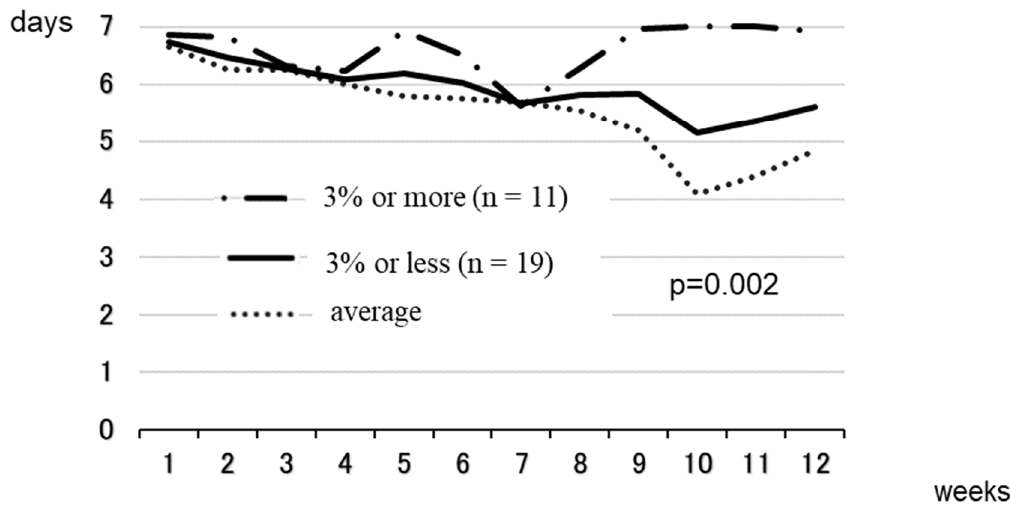
Figure 3. Mean days of wearing BCCG in each week for participants with 3% or more weight loss and those with 3% or less weight loss. BCCG, body compression corrective garment. p -value is for the interaction between time and groups in repeated measures mixed models .